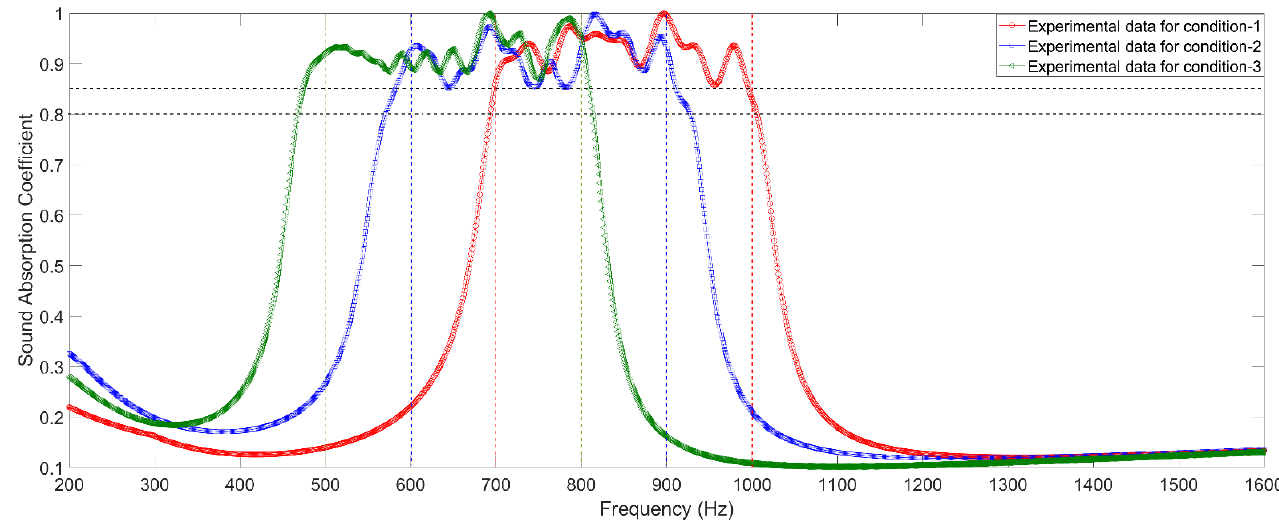
Figure 10. Distributions of actual sound absorption coefficients of the three optimized metamaterial cells obtained by the standing wave tube measurement.